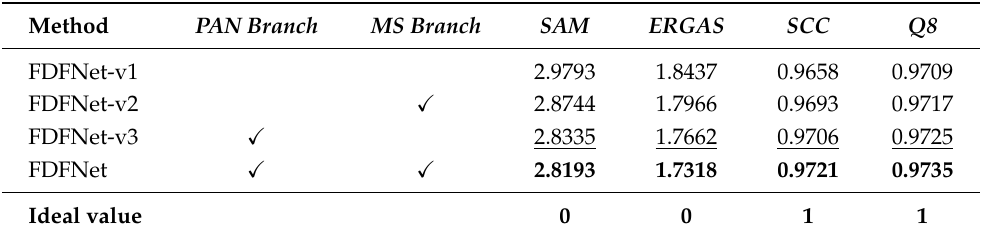
Table 8. Ablation study on the Rio dataset. The best performance is shown in bold and second place is